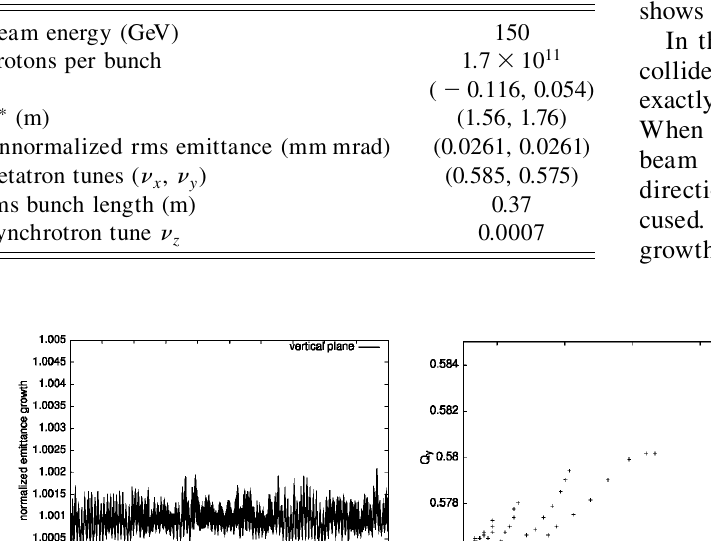
TABLE I. The nominal parameters for the weak-strong beam-beam interaction.